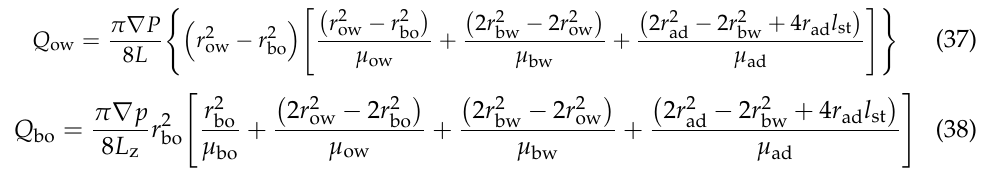
Figure 11. The comparisons of fluid velocity profiles in quartz nanopores calculated by “ liquid − liq- uid slip” model with molecular simulation data : ( a ) 5nm pore with OMP = 50%; ( b ) 5 nm pore with OMP = 60%; ( c ) 10 nm pore with OMP = 40%; ( d ) 10 nm pore with OMP = 60%.